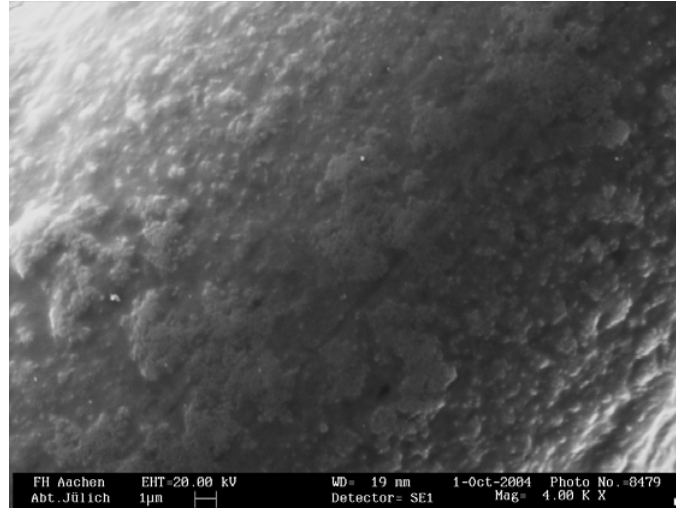
Figure 5. SEM image of the sensor surface with a magnification of